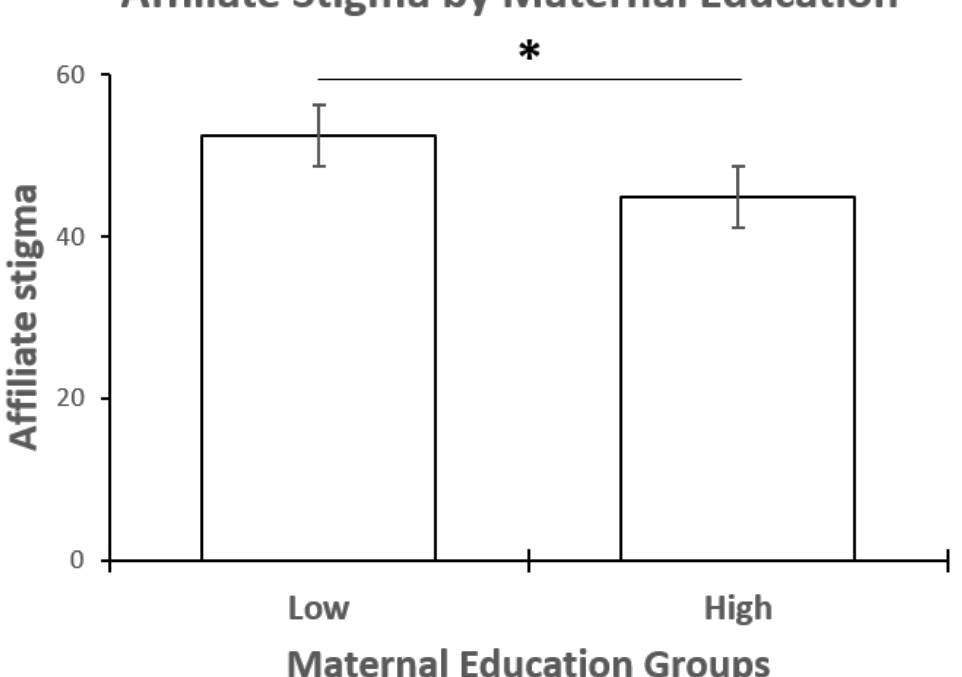
Figure 1. Group means of affiliate stigma scores by maternal education group. * = p =